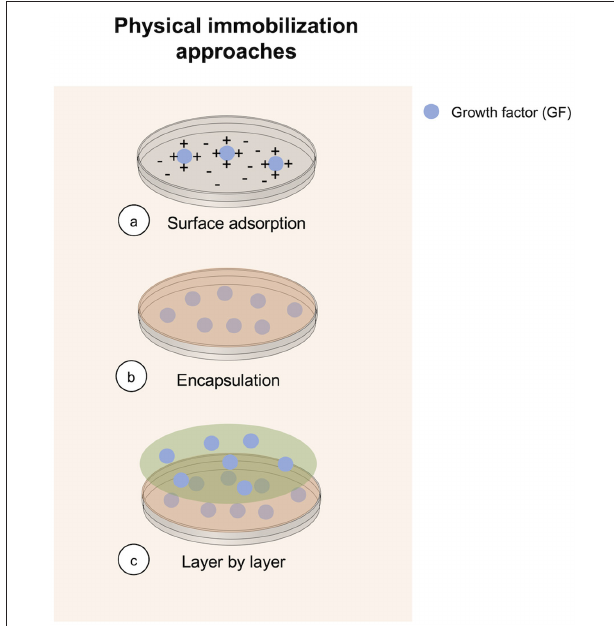
FIGURE 1 | Overview of methods currently in use to perform physical GF immobilization.